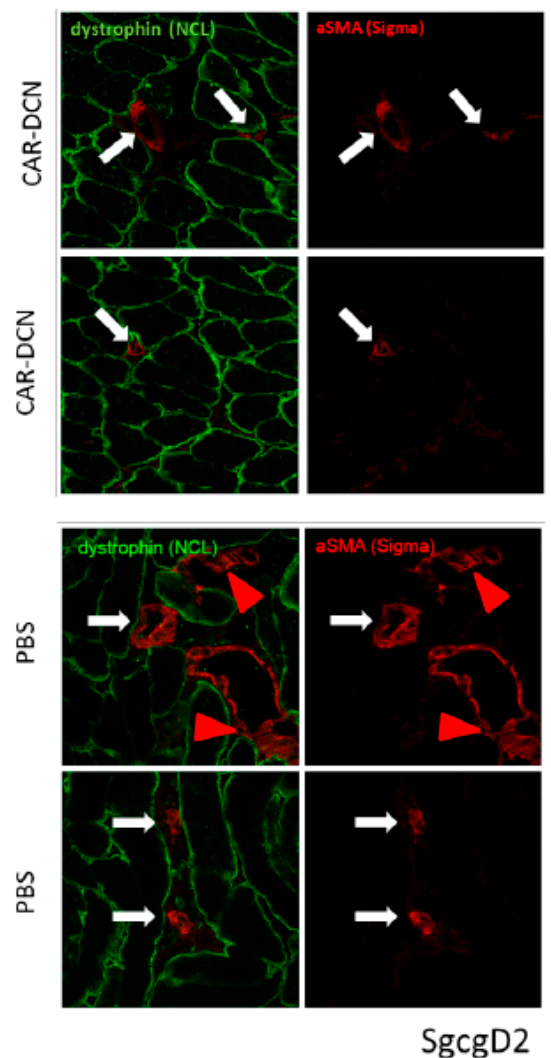
Figure 6. Three weeks of CAR-DCN treatment resulted in decreases in α smooth muscle actin staining in quadriceps muscle. SgcgD2 quadriceps were stained with dystrophin and α smooth muscle actin. The blood vessels from CAR-DCN treated mice had staining for α smooth muscle actin (white arrows, top four panels), but did not have extravascular staining (i.e., myofibroblasts). The PBS control quadriceps had both vessel staining (white arrows) and extracellular staining (red arrowheads, bottom four panels) indicating myofibroblast transformation. In addition, the dystrophin staining appeared more uniform in the CAR-DCN treated mice. Original magnification 40×.